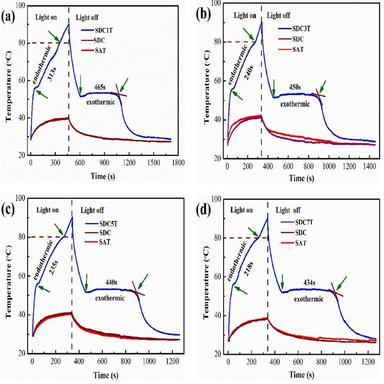
The temperature-time curves of SDC1T (a), SDC3T (b), SDC5T (c) and SDC7T (d) before and after lighting.